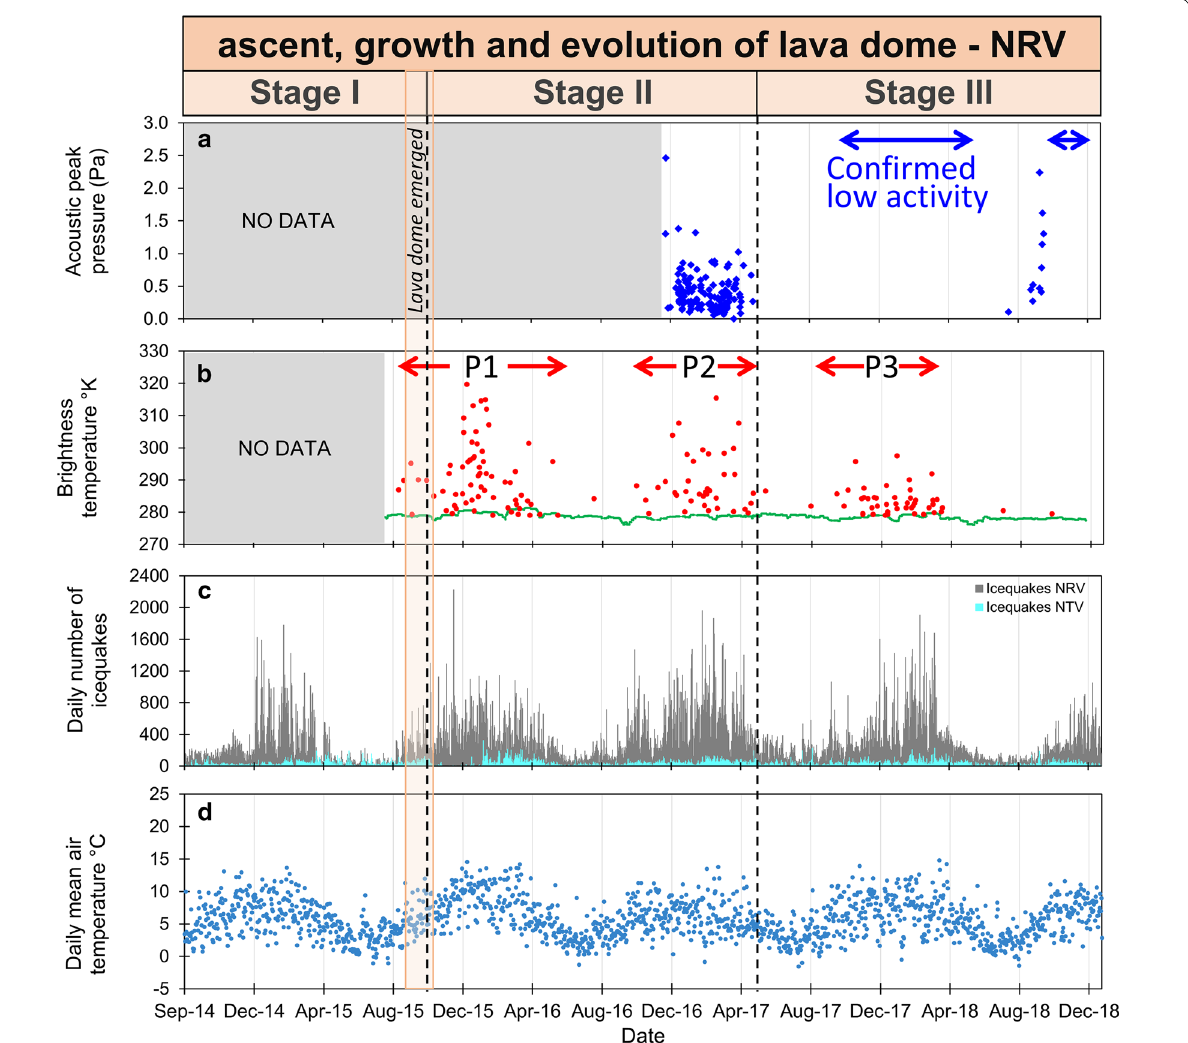
Fig. 8 Comparison of infrasound and thermal data with surface‑activity parameters recorded between September 1, 2014, and December 31, 2018. a Maximum pick pressure from the Chaparral sensor data at ACOLM station since December 2016. The periods shown by the blue arrows are the same as those in Fig. 7. b The same thermal anomaly data as in Fig. 4b. c Daily counts of icequakes at NRV (gray) and NTV (light blue). d Air temperature recorded by OLLETA weather